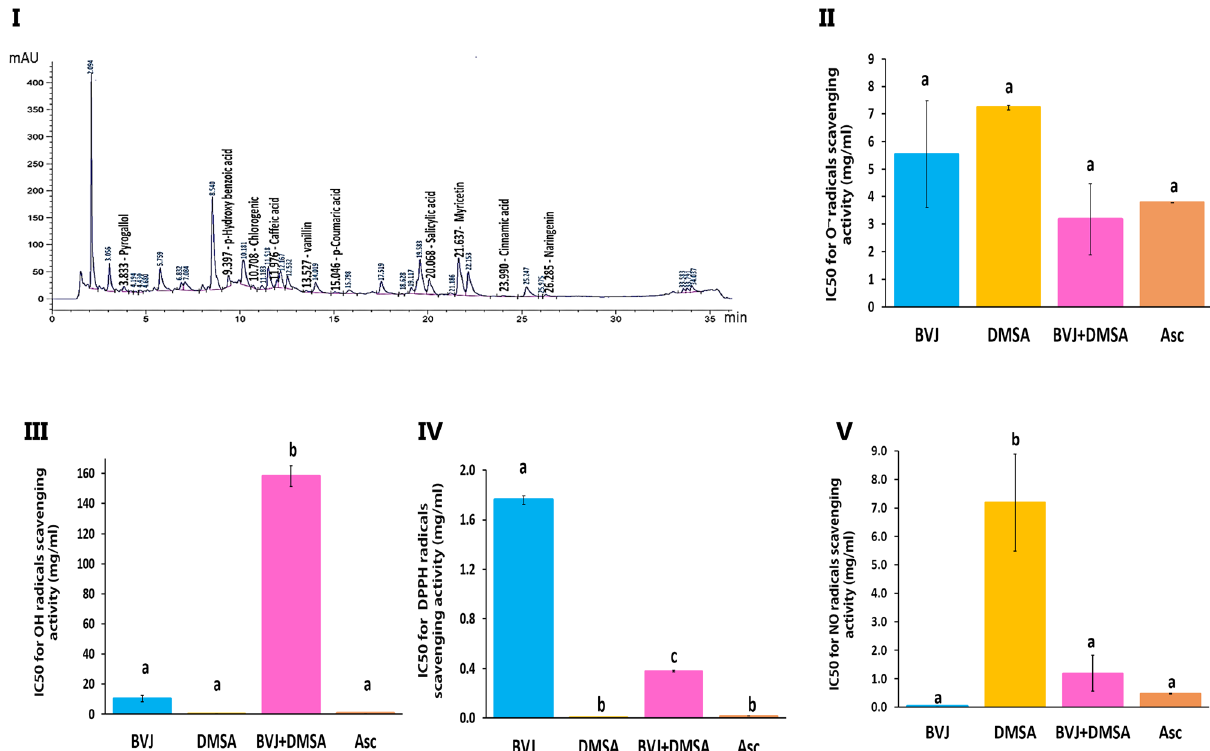
Figure 1. HPLC analysis and in vitro antioxidant activities of Beta vulgaris juice (BVJ), dimercaptosuccinic acid (DMSA), and their combination (BVJ + DMSA) compared to ascorbic acid (Asc). Where ( I ): HPLC analysis of BVJ, ( II ): superoxide radical (O· ‾ ) scavenging activitiy, ( III ): hydroxyl radical (OH − ۰ ) scavenging activity, ( IV) : α,α-diphenyl-β-picrylhydrazyl (DPPH) scavenging activity, and ( V ) nitric oxide (NO), scavenging activity. The results are shown as mean ± SE (n = 3). Different letters for the same parameter are significantly different at p < 0.05. Groups C Pb BVJ +